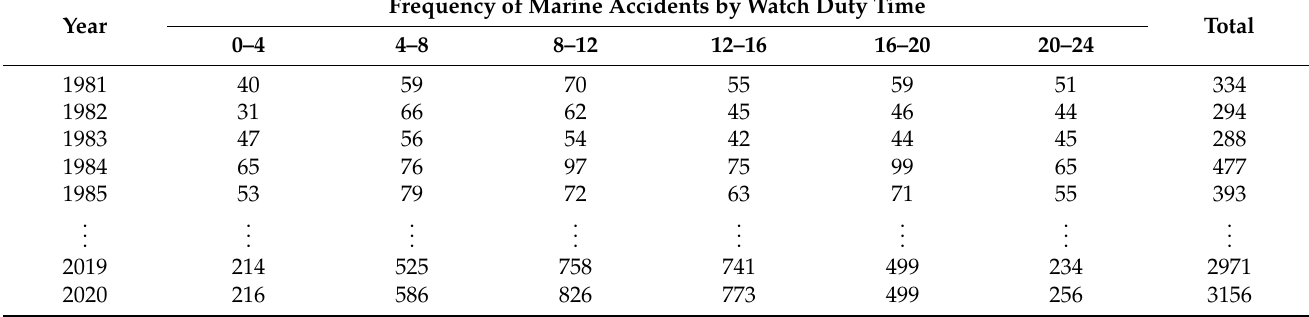
Table 2. Sample of processed data.